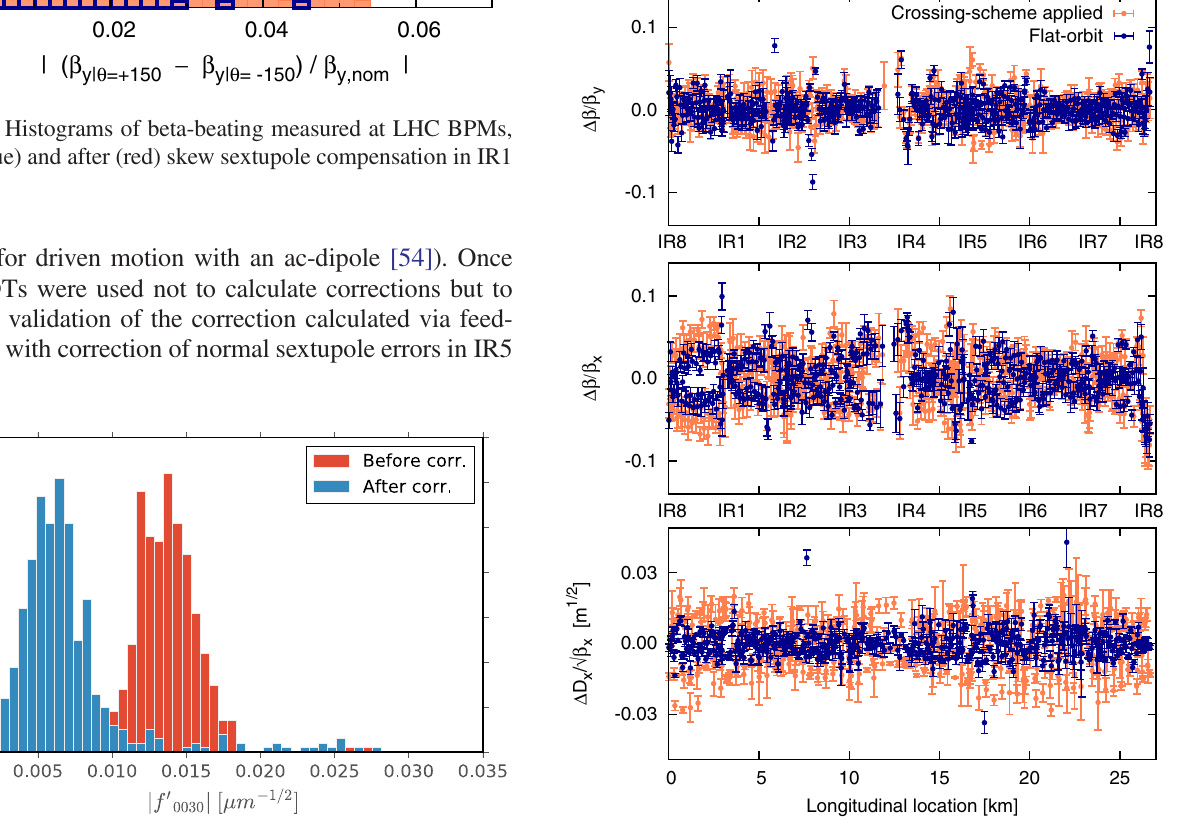
FIG. 25. Beta-beating (top,center) and normalized dispersion (bottom) of LHC Beam 2, measured at flat orbit after application of global linear optics corrections, and at the operational crossing scheme after application of all nonlinear corrections in